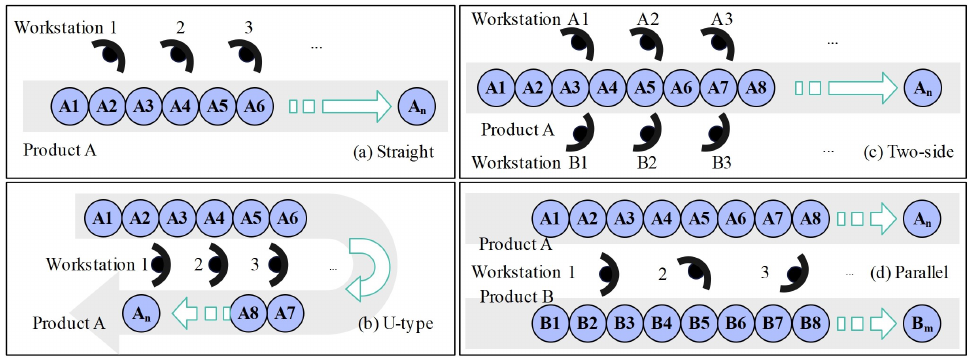
Figure 1. Layout type of disassembly